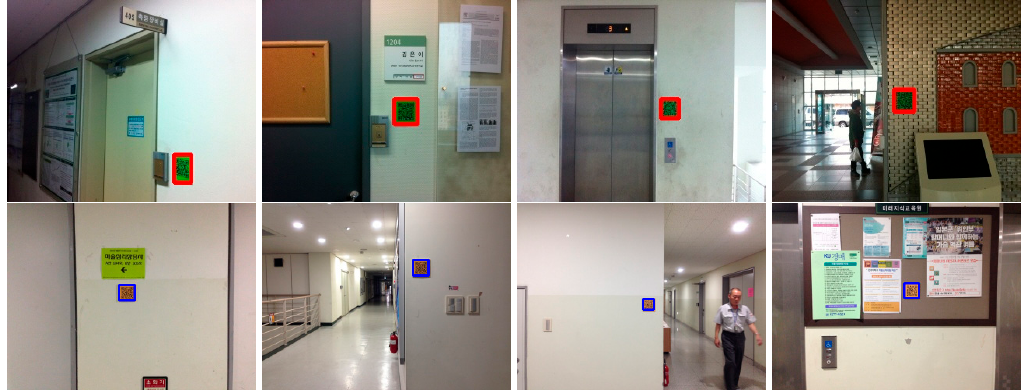
Figure 12. Examples of QR code localization results on real scenes.